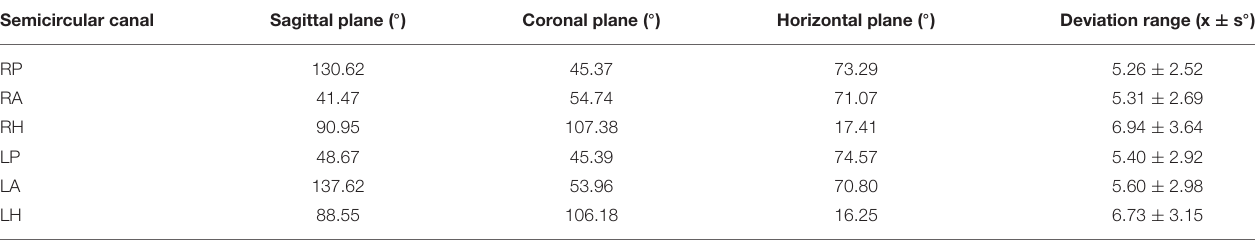
TABLE 1 | Calculate the angle between the plane of the semicircular canal and the coordinate plane by the vector method. Semicircular canal